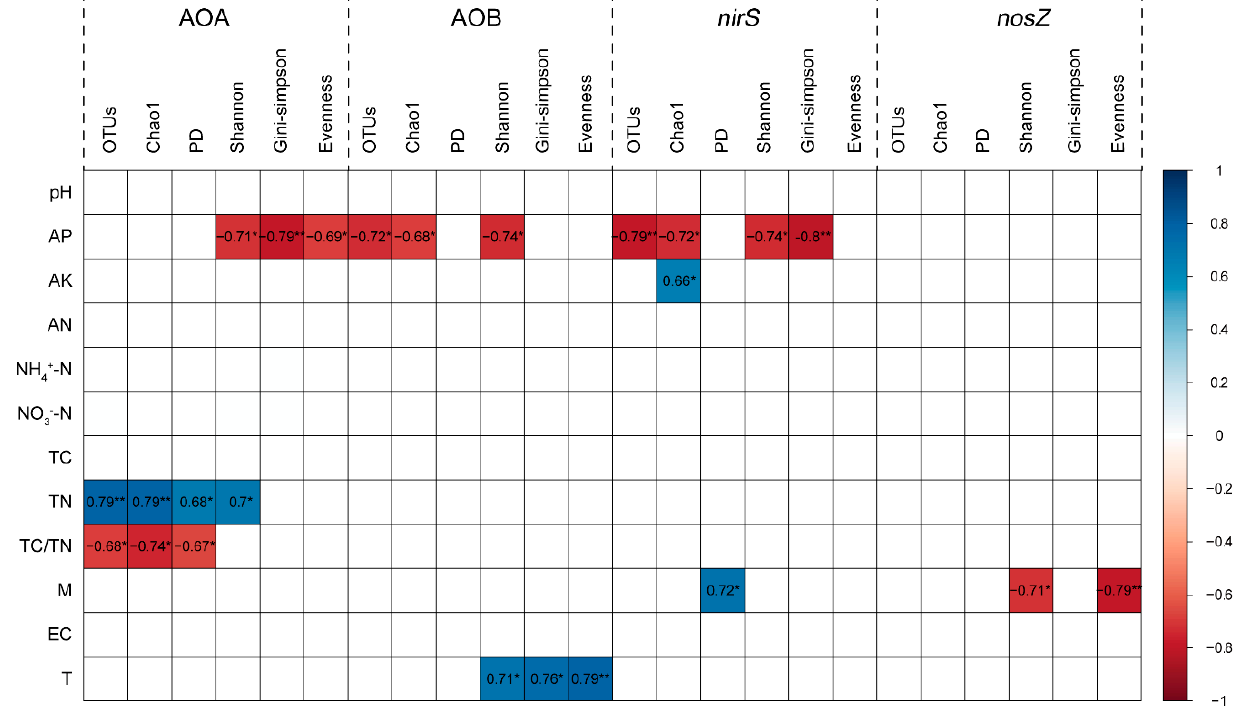
Figure 3. Pearson correlations between alpha diversity indices of functional genes and soil physicochemical properties. AP: available P; AK: available K; AN: alkaline N; NH 4+ -N: ammonium-N; NO 3 − -N: nitrate-N; TC: total C; TN: total N; M: soil moisture; EC: soil electrical conductivity; T: soil temperature. OTUs: observed number of OTUs; Chao1: Chao1 richness index; PD: phylogenetic diversity index; Shannon: Shannon diversity index; Gini–Simpson: Gini–Simpson index; Evenness: Shannon’s evenness index. Cell entries are Pearson correlation coefficients (r) between two indices. Only significant correlations are shown. * p < 0.05, ** p < 0.01.